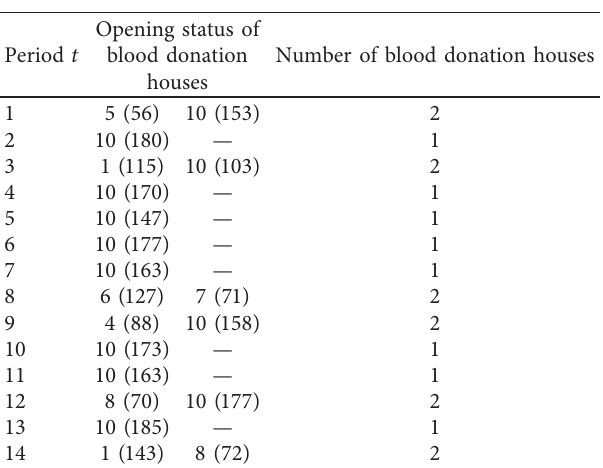
Table 8: Number of blood donation houses open and blood collected in each period.